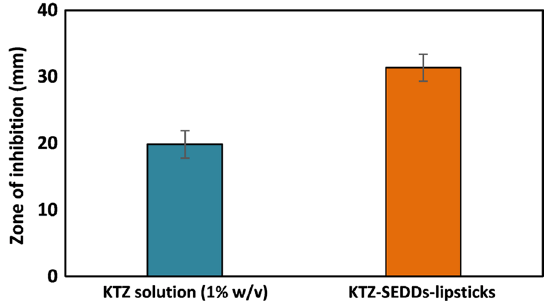
Fig. 5 In vitro antifungal activity of KTZ solution (1% w/v) and KTZ-SEDDs-lipsticks against C.